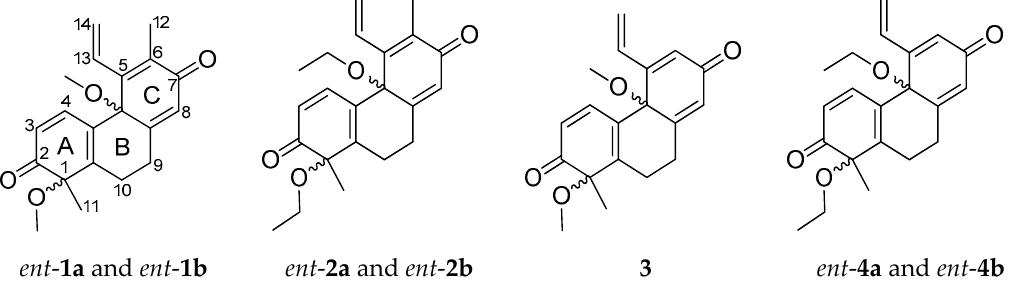
Figure 1. The structures of semisynthetic derivatives of juncusol ( 1 , 2 ) and effusol ( 3 , 4 ).